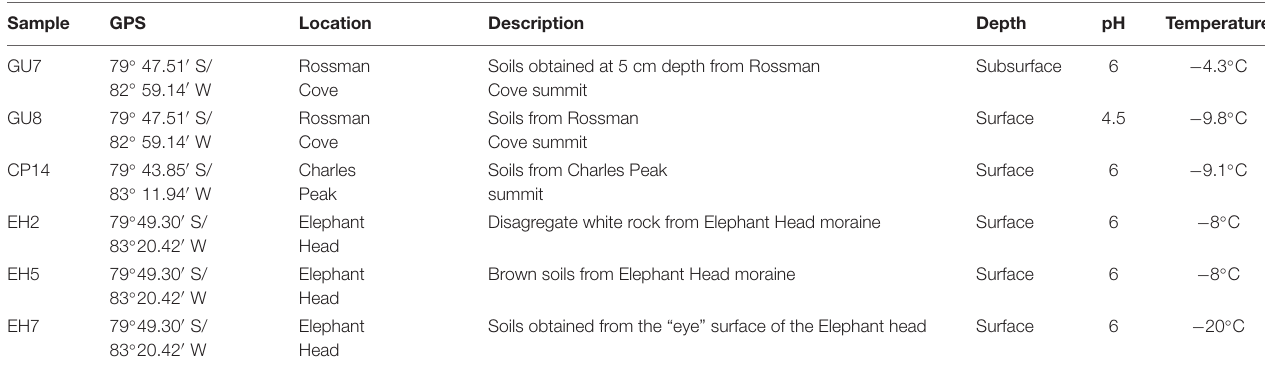
TABLE 1 | Summary of the environmental samples from the Union Glacier area. Sample